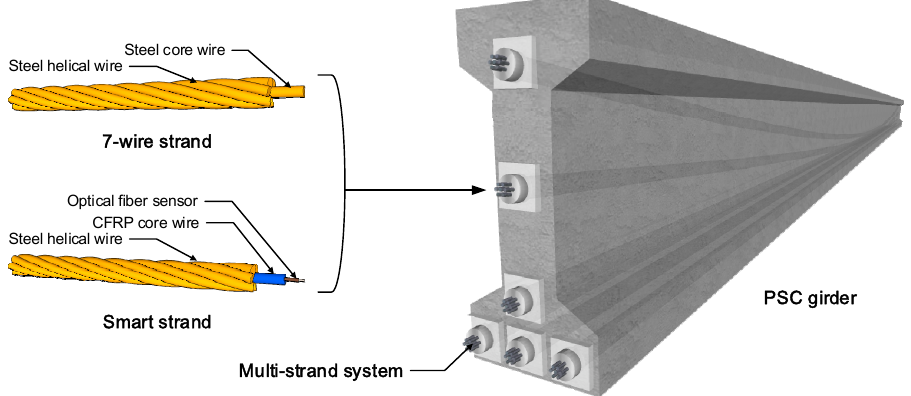
Figure 1. Prestressed concrete (PSC) structure with multi-strand system.